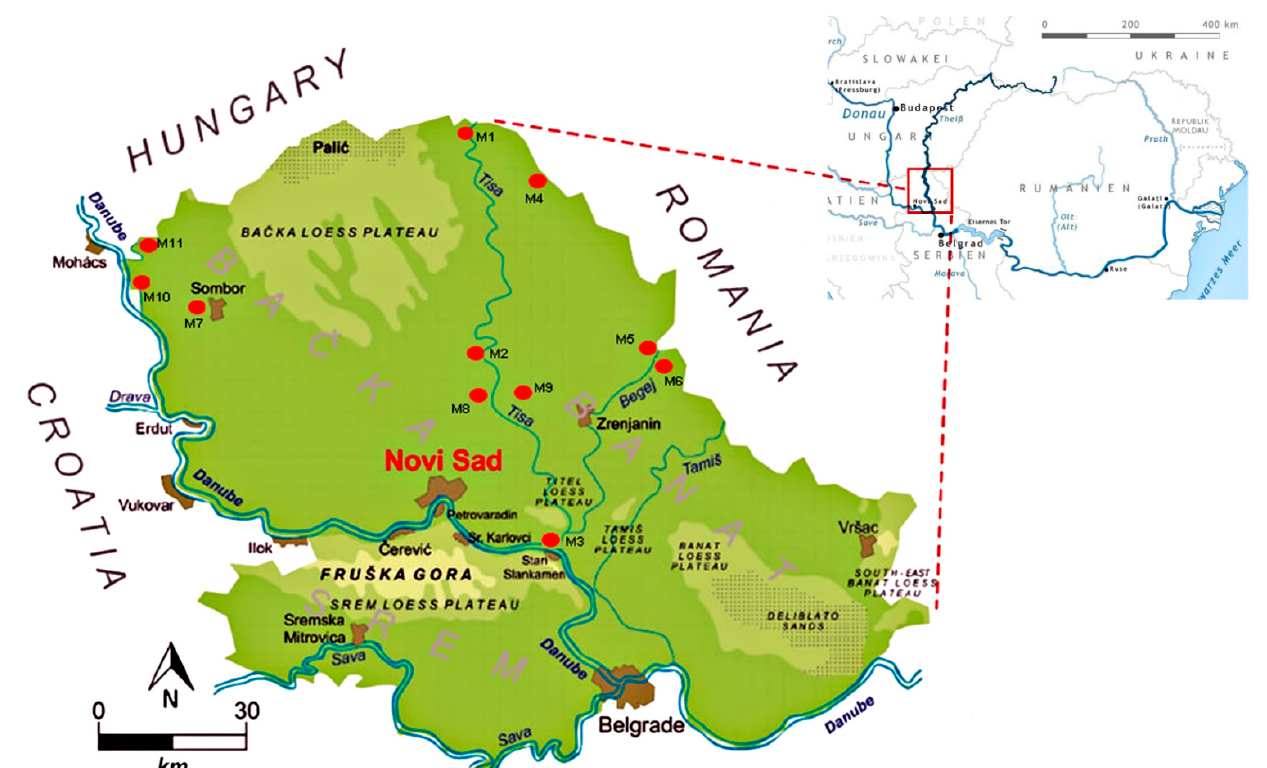
Figure 1. The Tisa River basin in Serbia.